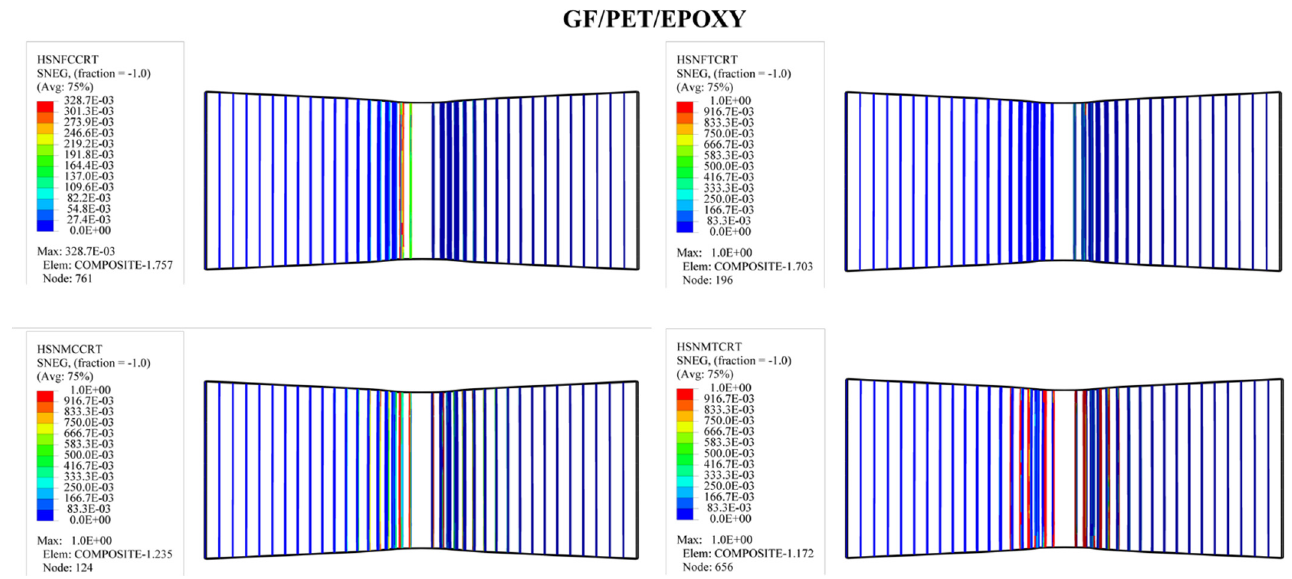
Figure 13. Numerical Hashin’s damage initiation of the upper skin of GF/PET/Epoxy sandwich composites.